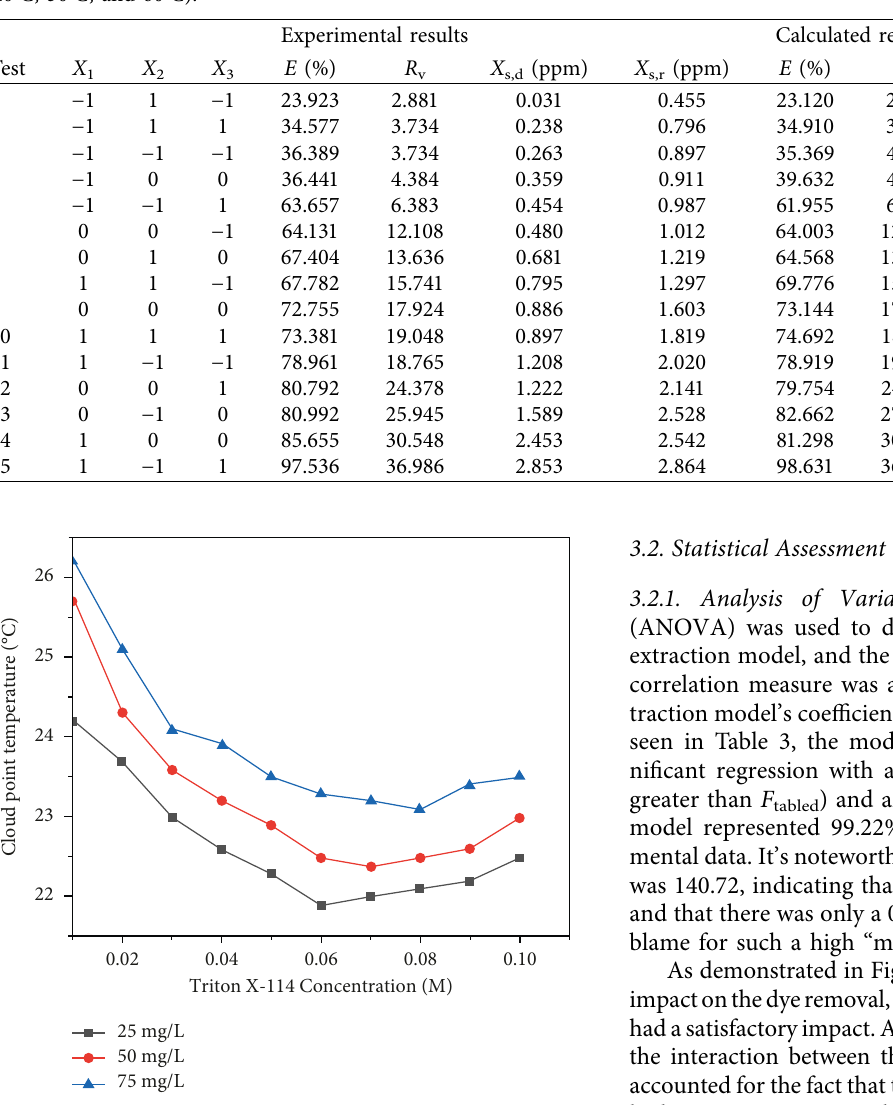
Figure 4: (a) Response surface for dye extraction in (%). (b) Effects of variables on dye extraction in the Pareto chart. (c) Coherence between predicted and observed values of % of